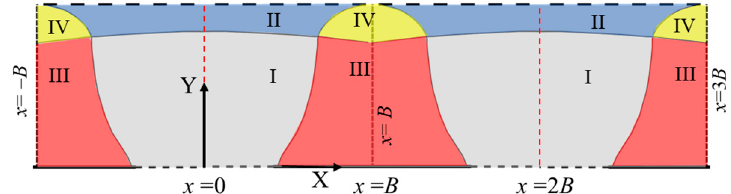
Figure 7. General well-location zones with respect to di ff erent types (from I to IV) of the catchment zone.